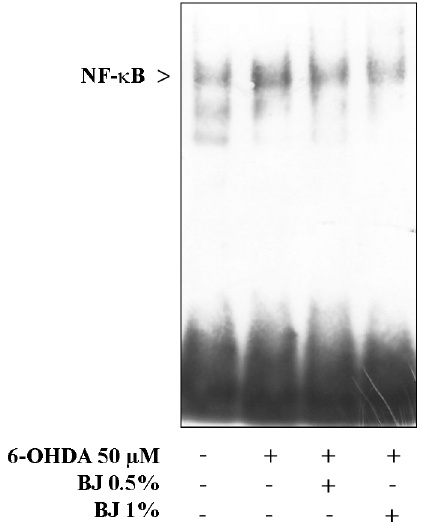
Figure 7. BJ reduces the activation of NF-kB induced by 6-OHDA. The gel electromobility shift assay (EMSA) analysis showing the nuclear translocation of NF-kB was performed after the exposure of differentiated cells to 6-OHDA subsequent to a pre-treatment with BJ. A representative image of two independent experiments is displayed.